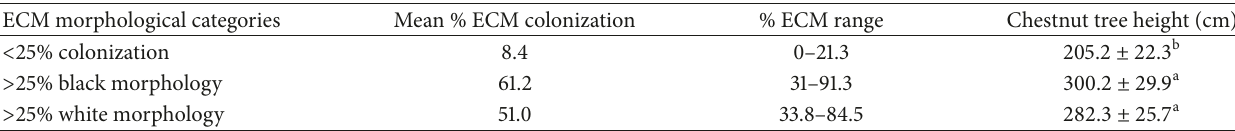
Table 2: Eight-year-old chestnut trees (tree types pooled) compared by three ECM categories: (1) those with < 25% ECM root colonization ( 𝑛 = 19 ), (2) colonization greater than 25% with black hyphae and sheaths ( 𝑛 = 18 ), and (3) colonization greater than 25% with white hyphae and fungal sheaths ( 𝑛 = 13 ). Error bars are ± 1 standard error and different letters indicate statistical differences at 0.05.